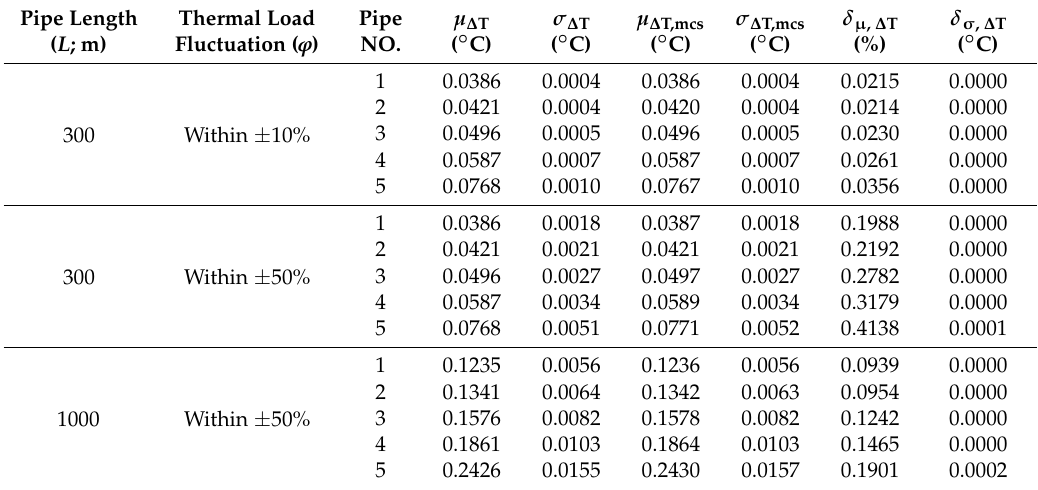
Table 7. Typical mean and standard deviations of pipe temperature drops. (Test 3: µ ϕ = 0.5 MW).